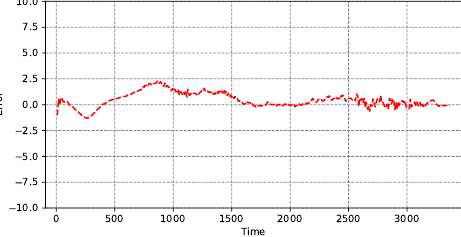
( d ) Error curve of battery capacity = 90%